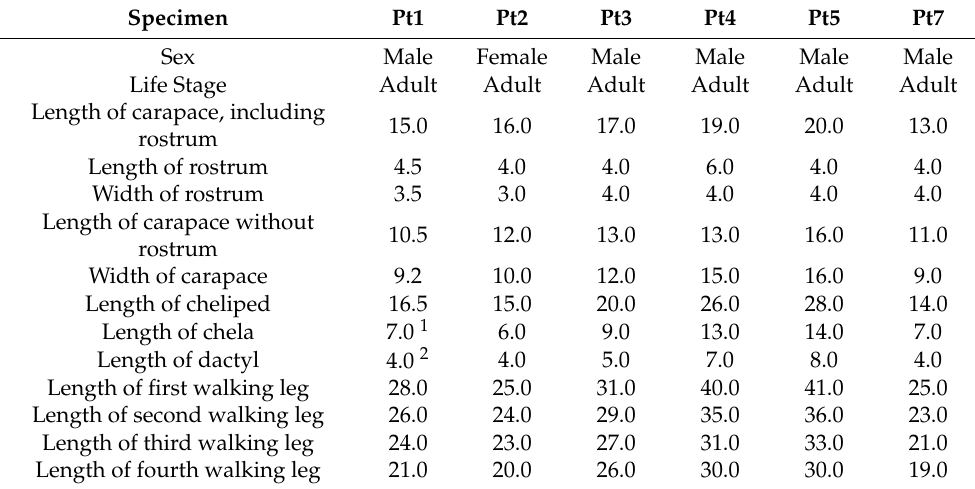
Table 2. Sex, life stage and measurements (mm), of Pyromaia tuberculata specimens collected in the Tagus estuary,